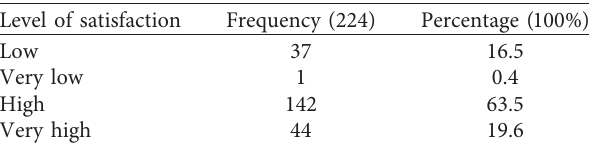
Table 4: Respondents’ level of satisfaction with the clinical learning environment.